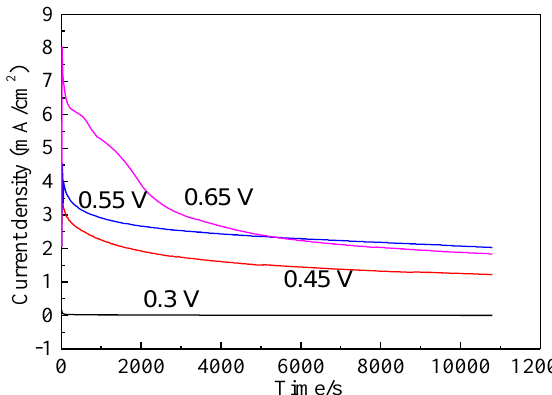
Figure 9. Current-time curves of bornite electrode at different applied potentials for 3 h in 9K bacterial culture medium (Conventional three-electrode system on a Princeton Model 283 Potentiostat, EG&G of Princeton Applied Research).